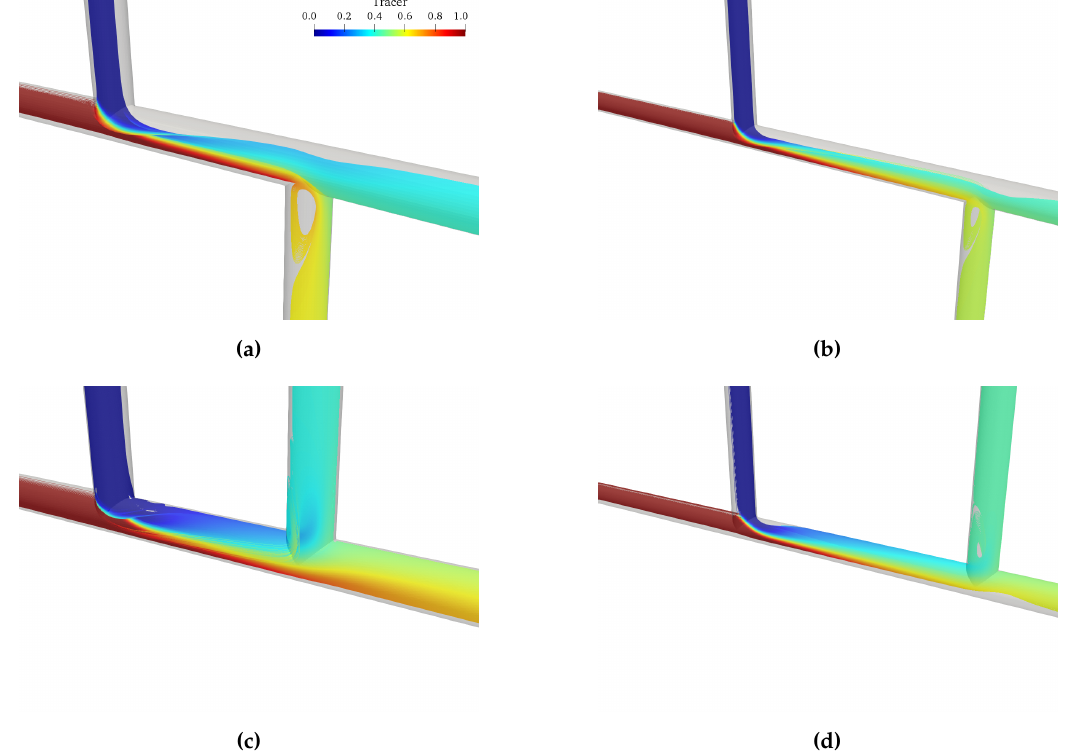
Figure 9. CFD tracer streamlines visualization for identical inlet flow ratio: ( a ) Configuration S, 5.6D, ( b ) Configuration S, 10D, ( c ) Configuration U, 5.6D, ( d ) Configuration U,